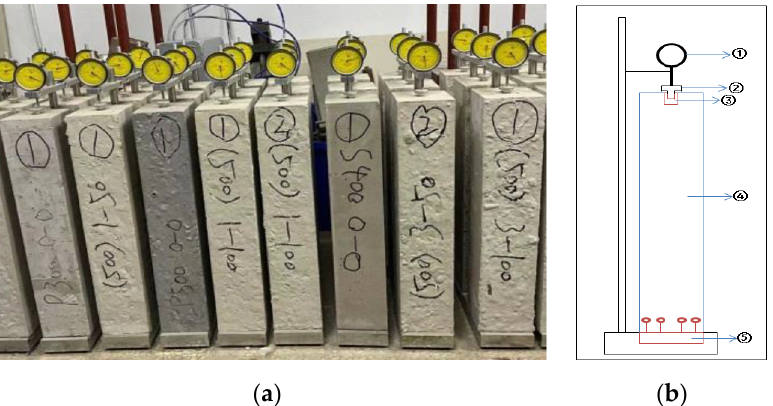
Figure 3. Concrete shrinkage dilatometer: ① dilatometer, ② fixed small platform, ③ internal twist screw, ④ test block, and ⑤ fixed small platform. ( a ) Equipment appearance and ( b ) working principle.